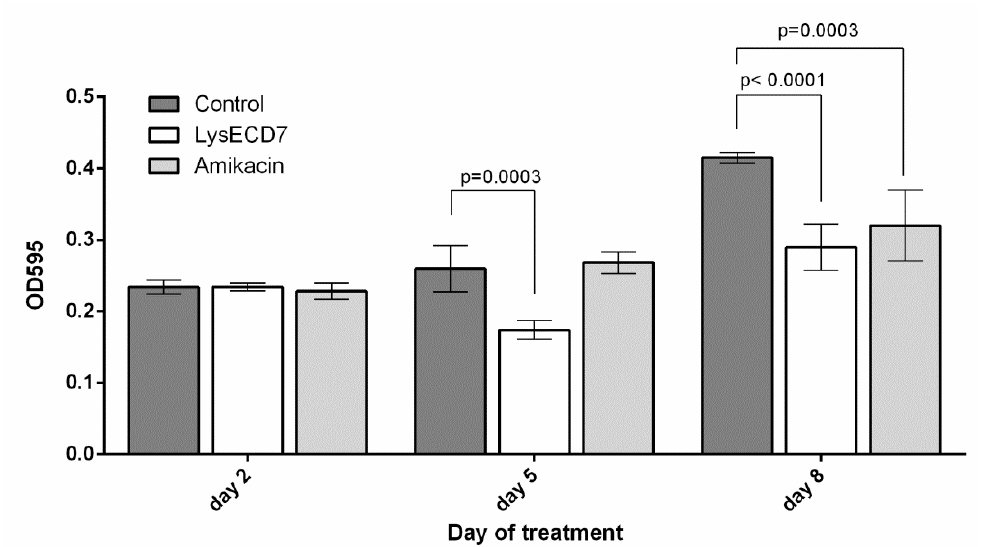
Figure 6. Dynamics of the biomass of biofilms in diffusion chambers in vivo during performed therapy. Data are shown as mean ± standard deviation. Significant differences with the vehicle control group are shown as p values, otherwise no statistical difference was found (two-way ANOVA with Dunnett’s multiple comparisons test).